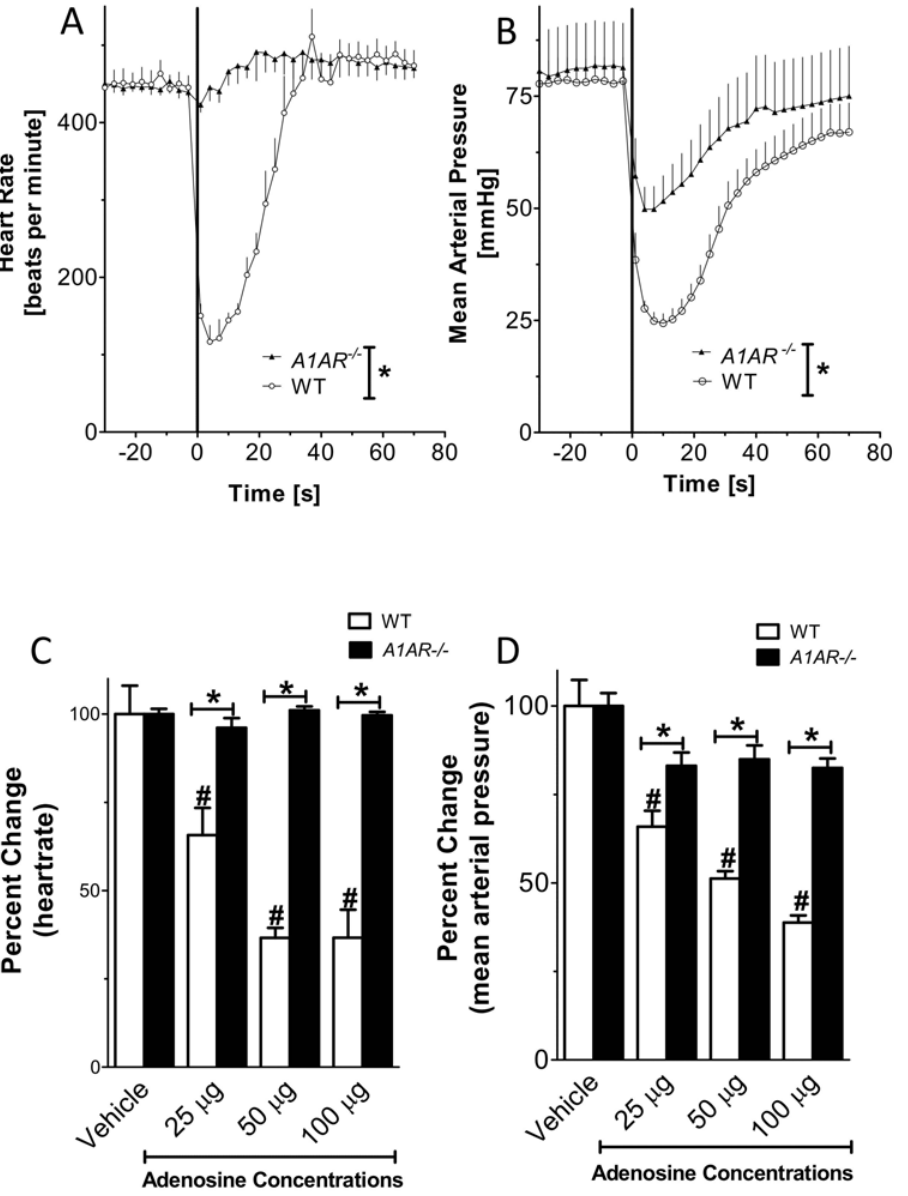
Figure 3. Adenosine bolus injections in gene-targeted mice for the A1AR. Following insertion of a catheter into the common carotid artery, mean arterial blood pressure and heart rate were measured A1AR 2 / 2 -mice received bolus injection of vehicle or indicated doses of adenosine (100 m l) via the carotid artery catheter. (A, B) Heart-rate and blood pressure responses to 100 m g of adenosine compared to wild type mice. (C, D) Relative changes in heart-rate and mean arterial blood pressure. Note: A1AR 2 / 2 -mice experience no change in HR following bolus injection of adenosine. (n=7–8; WT n=8, *p , 0.05 A1AR 2 / 2 vs WT; # p , 0.05 compared to adenosine-vehicle; mean 6 SEM;).